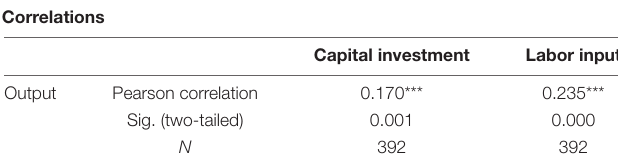
TABLE 3 | Pearson correlation coefficient between input and output variables.